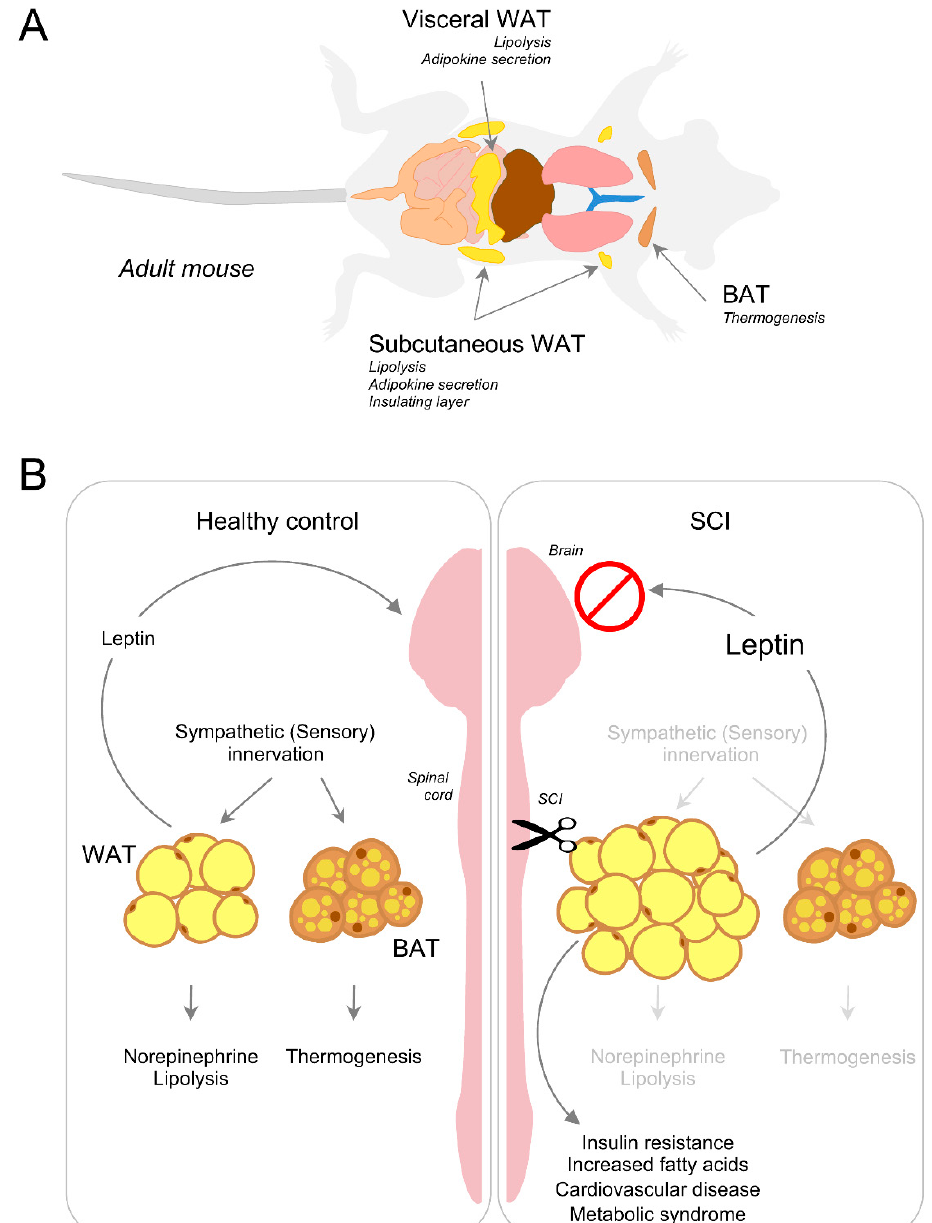
Figure 4. Adipose tissue depots, energy balance and leptin sensing. ( A ) Representation of adipose depots located under the skin and within the abdomen in adult mice. Whereas WAT can be subdivided into subcutaneous, bone marrow and visceral depots, BAT mainly localizes in the interscapular region. ( B ) Under normal physiological conditions, sympathetic innervation regulates WAT lipolysis and BAT thermogenesis. The contribution of sensory innervation is far less understood. Leptin action on the neurons located in the hypothalamus is critical for homeostatic regulation of energy balance. After SCI, interruption of adipose tissue innervation causes a breakdown in energy homeostasis leading to adipose tissue accumulation and ectopic lipid spillover to vital organs. If protracted, such detrimental conditions contribute to the development of insulin resistance, increased fatty acids, cardiovascular complications and metabolic syndrome.